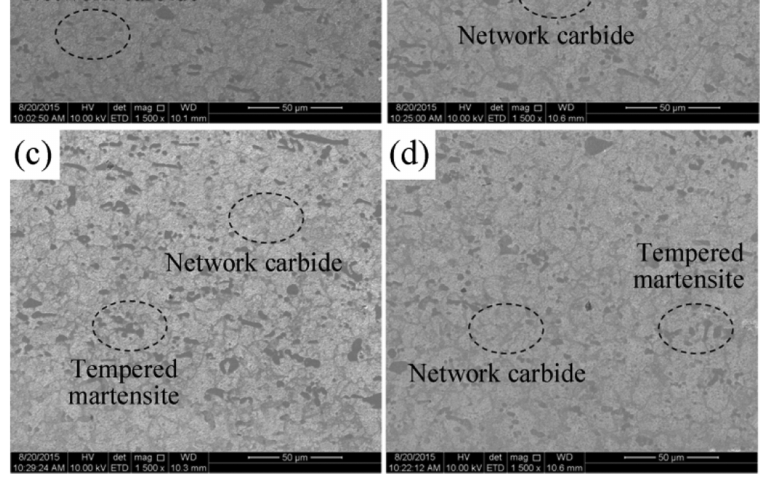
Figure 9: Microstructure of the heat affected zone.